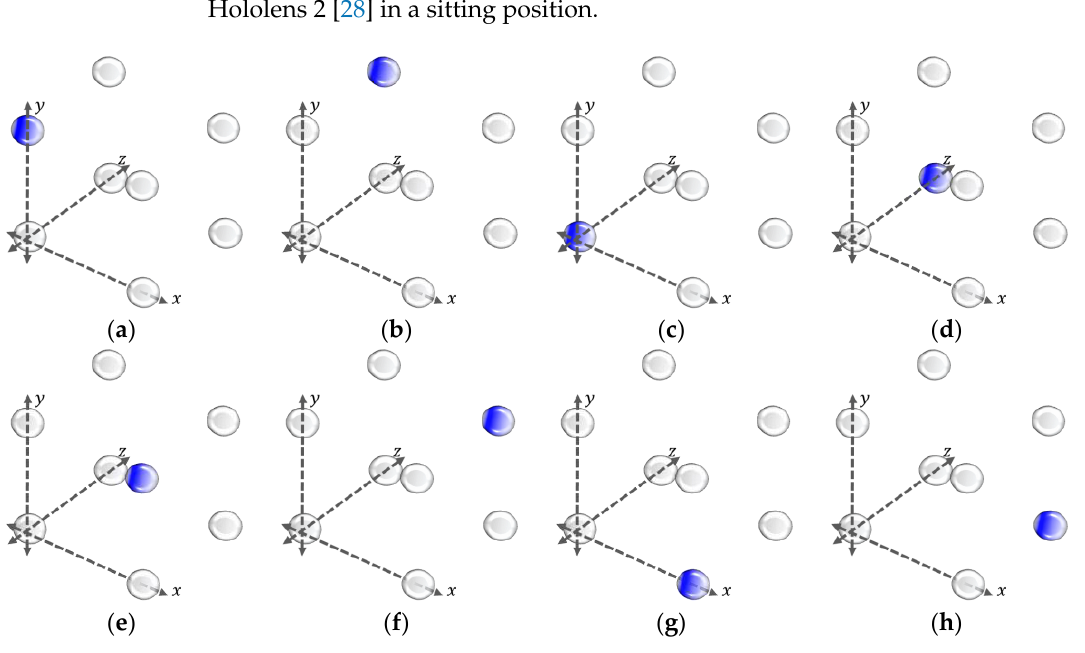
Figure 6. Various position examples where virtual objects were generated (8 cases): ( a ) left-top-front; ( b ) left-top-back; ( c ) left-bottom-front; ( d ) left-bottom-back; ( e ) right-top-front; ( f ) right-top-back; ( g ) right-bottom-front; ( h ) right-bottom-back.